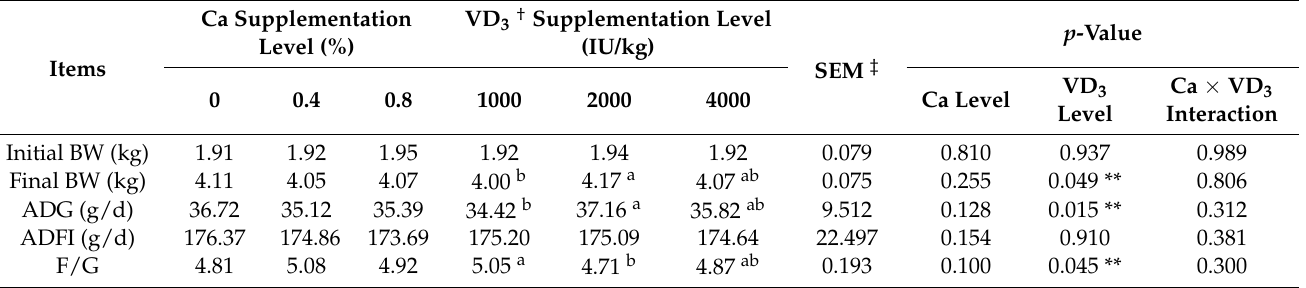
Table 2. Effects of dietary Ca and VD 3 supplemental levels on growth performance in growing blue foxes (LS means ± SEM).